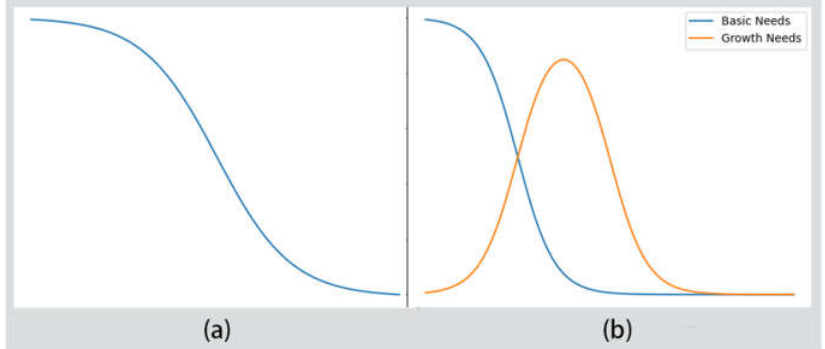
Figure 4. Functional representation of hierarchy of needs. ( a ) The raw wave function; ( b ) graph of the inhibition relationship for different need levels.